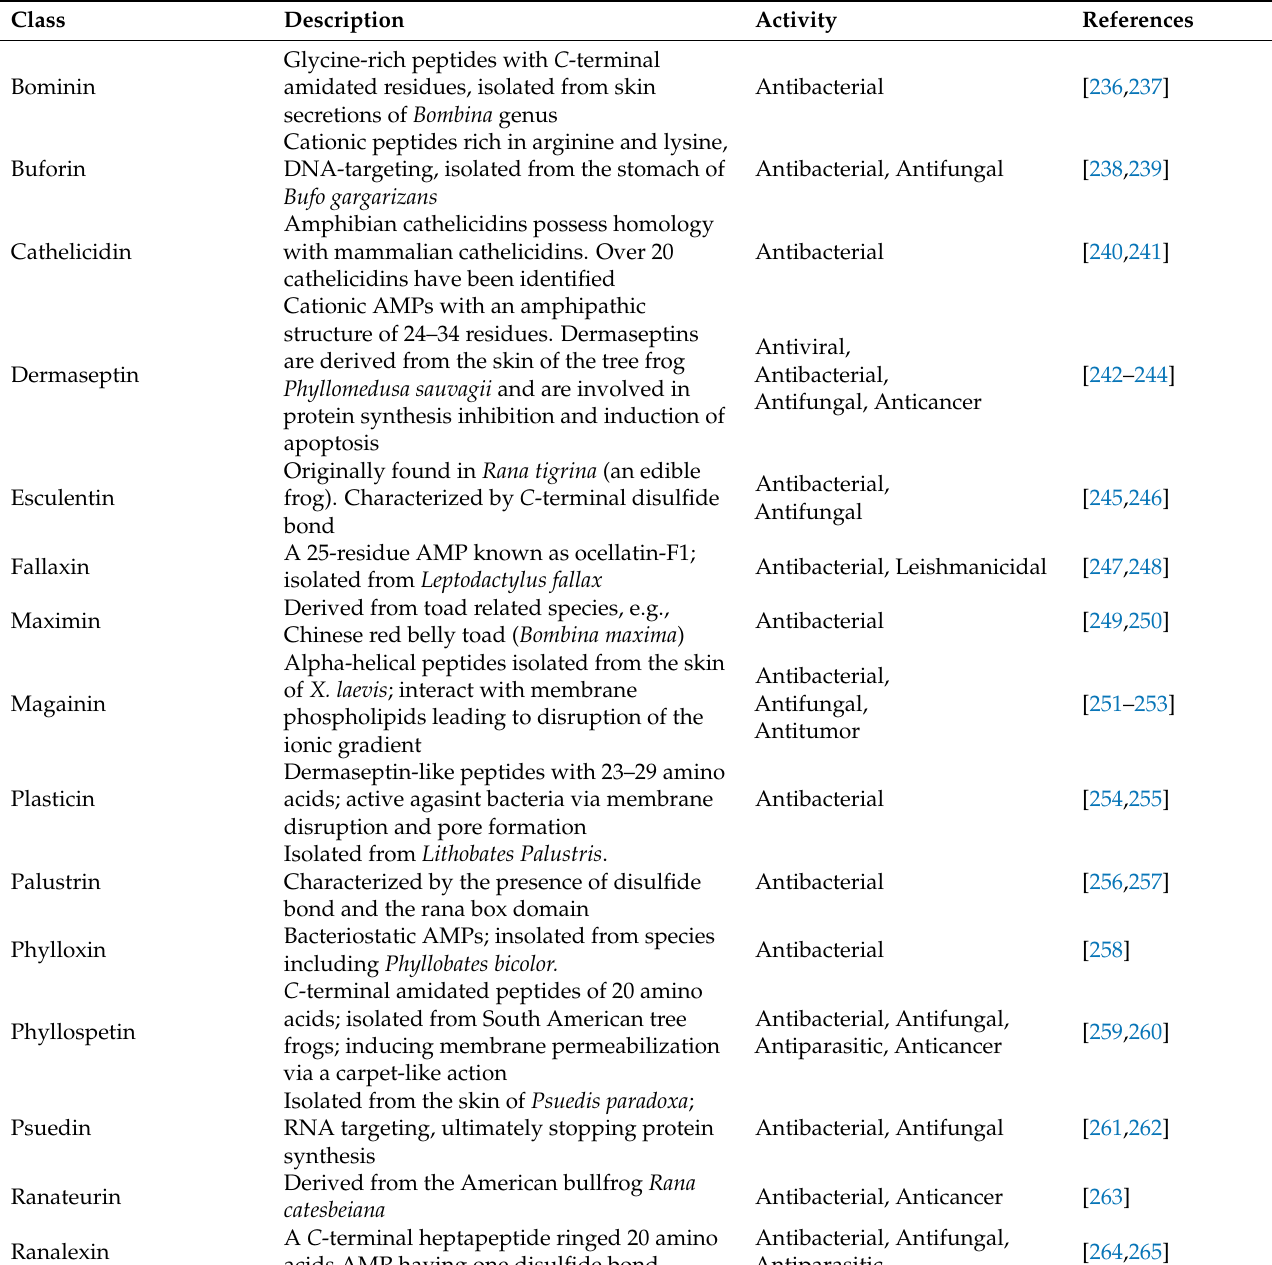
Table 2. Classification of Amphibians AMPs and their